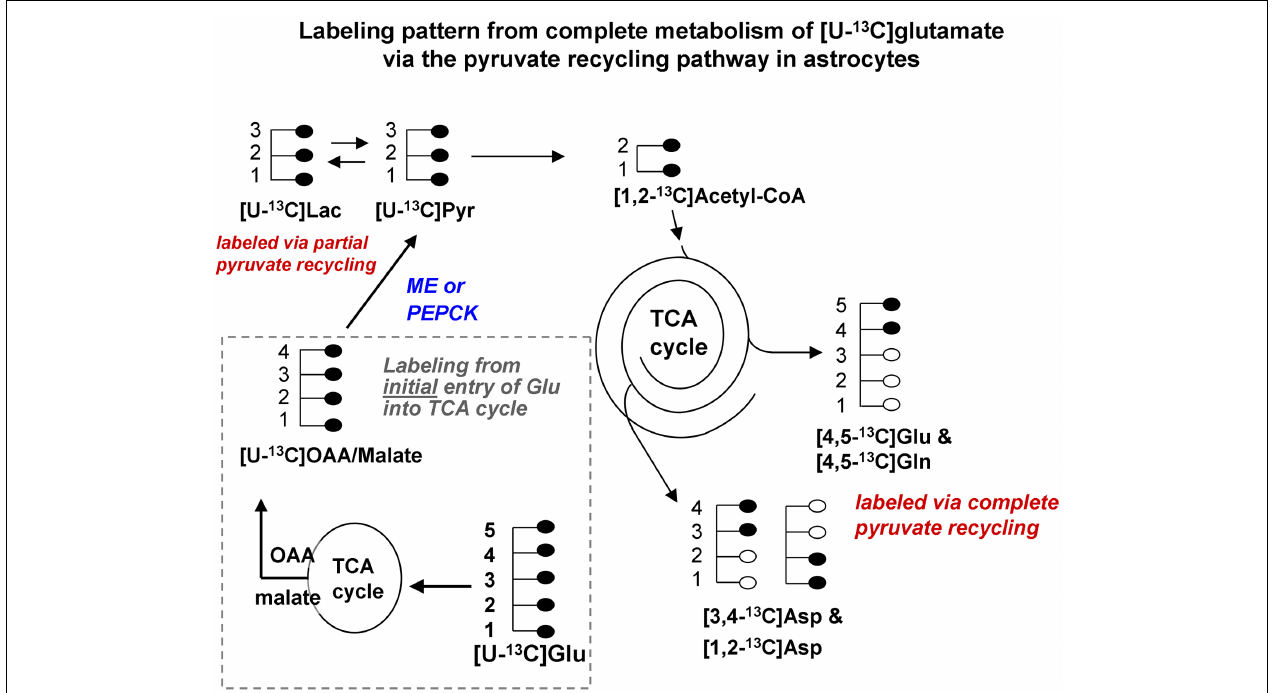
from the condensation of the [1,2- 13 C]acetyl CoA with unlabeled oxaloacetate in the cycle would give rise to [4,5- 13 C]glutamate and glutamine, and also to both [1,2- 13 C]aspartate and [3,4- 13 C]aspartate.These partially labeled glutamate, glutamine, and aspartate molecules can be readily distinguished from the [U- 13 C]glutamate, glutamine, and aspartate by 13 C-NMR spectroscopy. It is very likely that studies of pyruvate recycling from [U- 13 C]glutamate underestimate the amount of recycling taking place since any citrate formed from the condensation of [1,2- 13 C]acetyl CoA with [U- 13 C]OAA formed from the initial entry and metabolism of the glutamate into theTCA cycle give rise to [U- 13 C]glutamate which can not